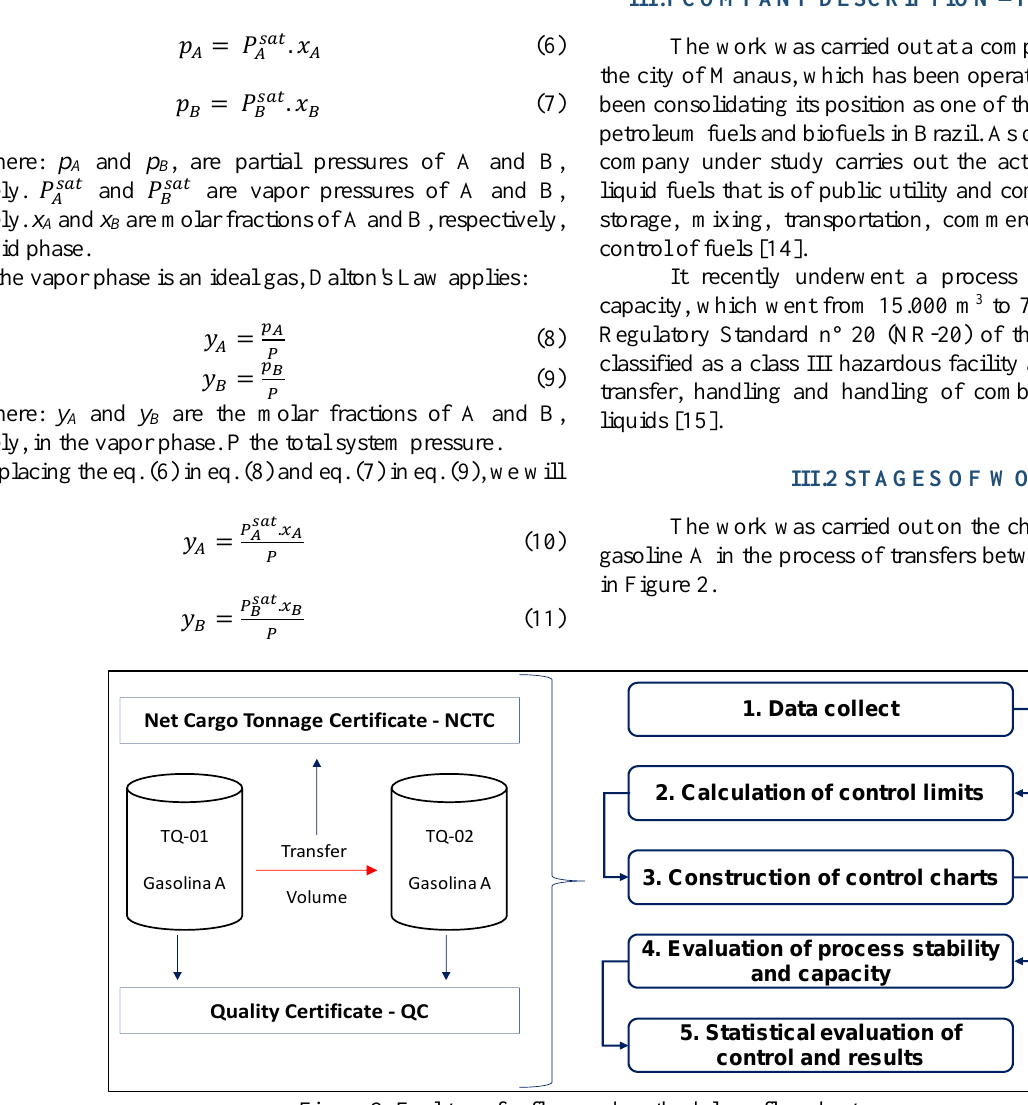
Figure 2: Fuel transfer flow and methodology